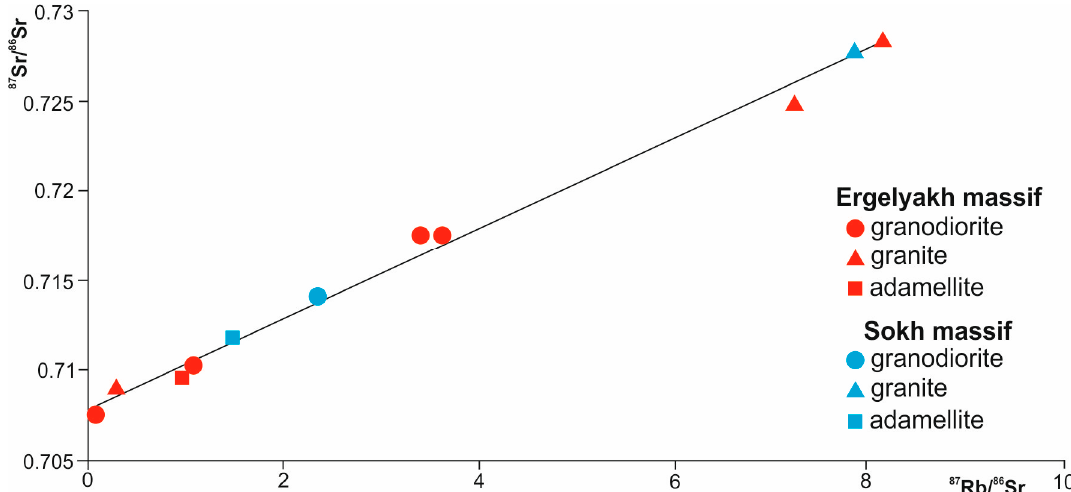
Figure 9. Rb ‐ Sr isocron diagram for granitoids of the Ergelyakh and Sokh massifs. Figure 9. Rb-Sr isocron diagram for granitoids of the Ergelyakh and Sokh Table 8. Model Sm–Nd age and parameters of protoliths for EIRGD granitoids.